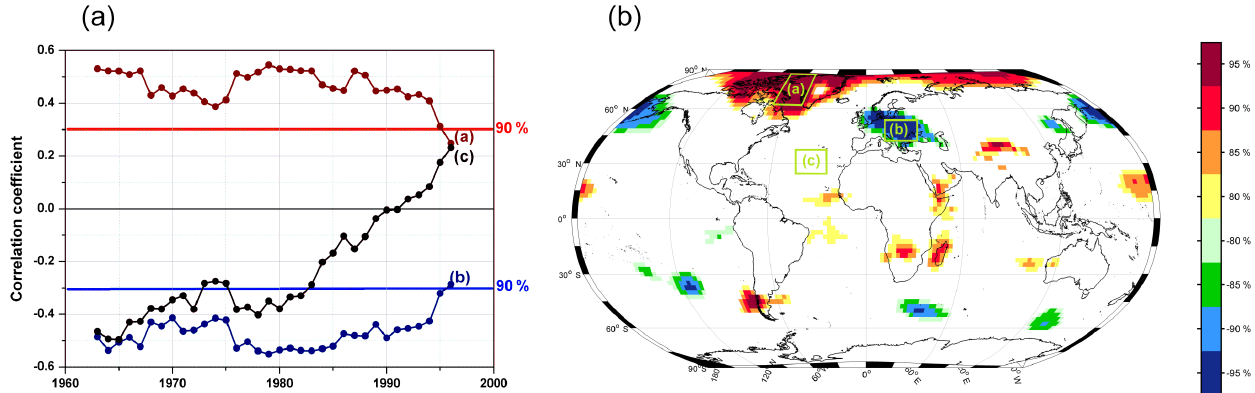
Figure 4. Example of a stability correlation map. (a) correlation between tri-monthly streamflow at Kaub/Rhine and SLP of the previous winter in a 31-year moving window for selected grid areas, (b) map showing the areas with the corresponding